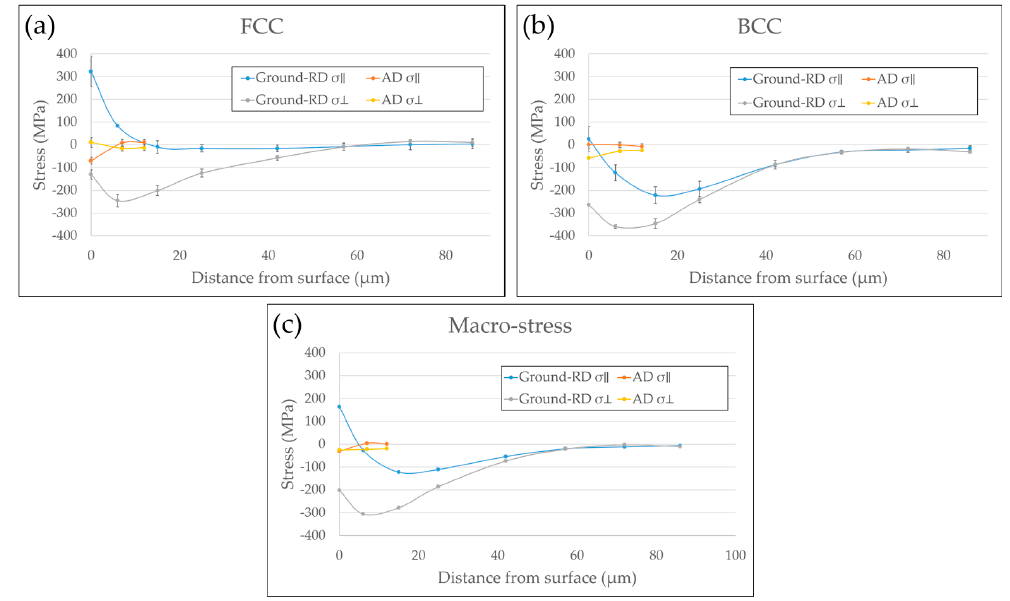
Figure 4. In-depth residual stresses of AD and Ground-RD specimens: ( a ) residual stresses in austenitic phase; ( b ) residual stress in ferritic phase; and ( c ) macro-stress. Positive values denote tensile stresses and negative compressive stresses.